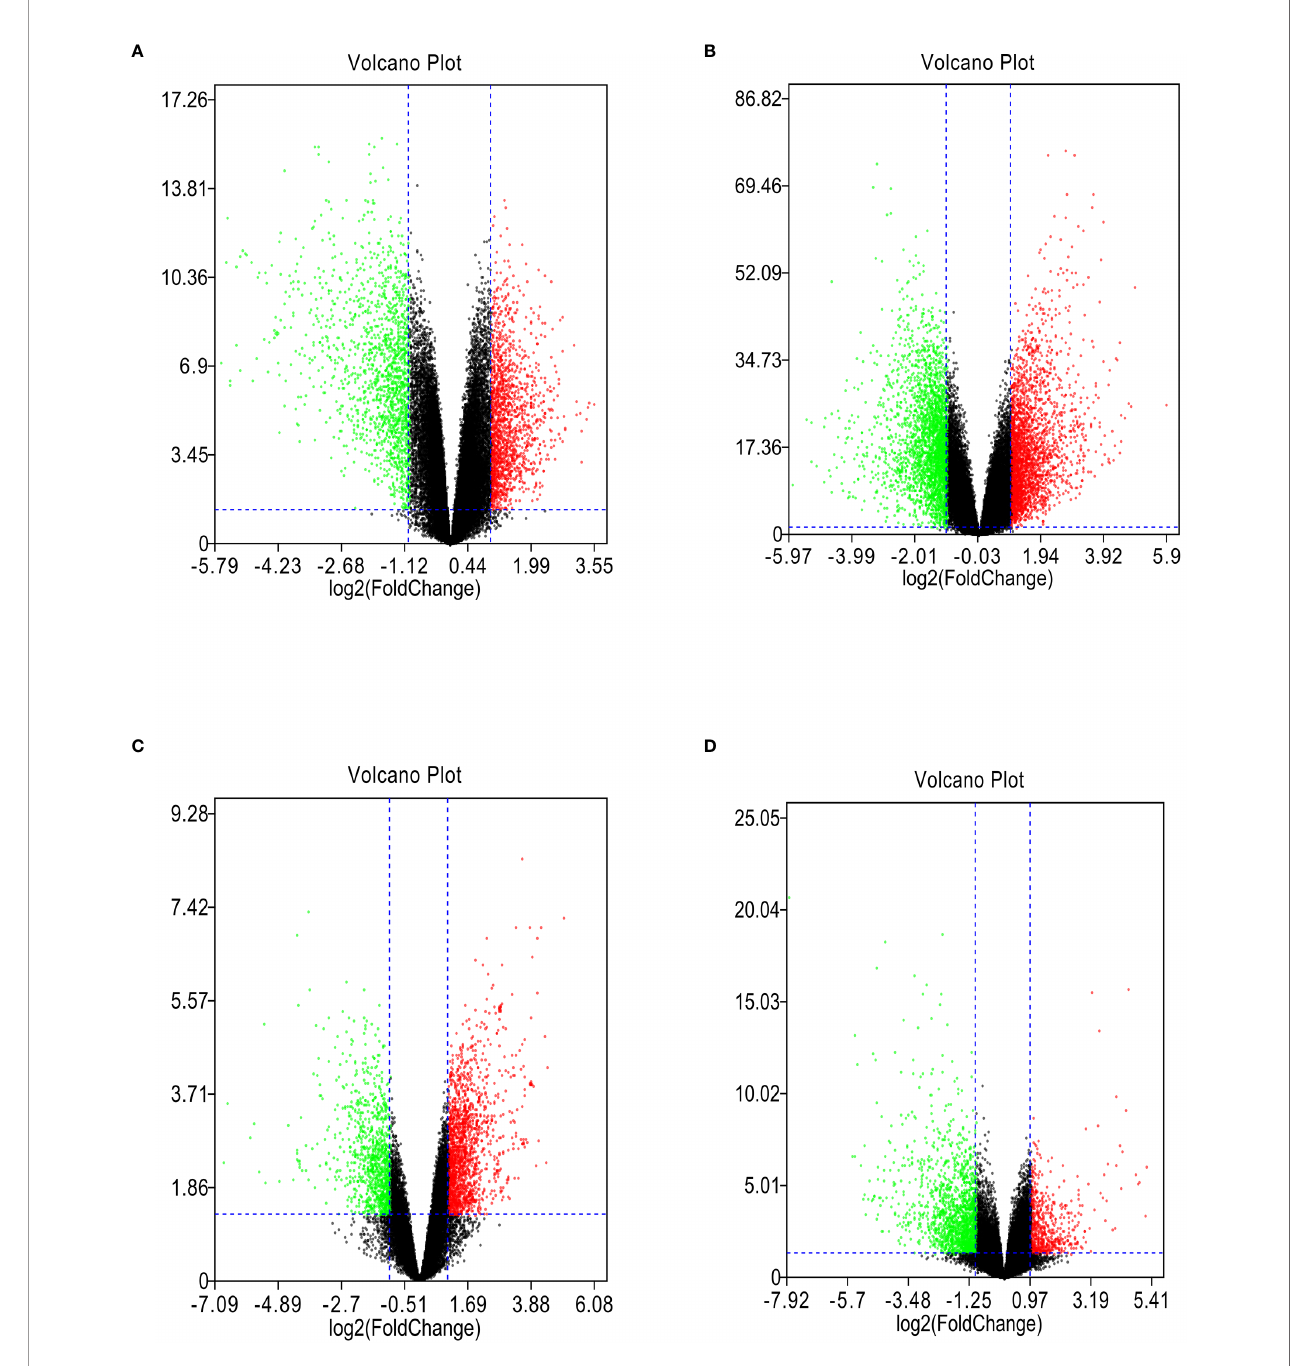
FIGURE 2 | (A) The volcano plot illustrates the differences between control and gastric cancer tissues after analysis of the GSE118916 dataset with GEO2R. (B) The volcano plot illustrates the difference between control and gastric cancer tissues after analysis of the GSE54129 dataset with GEO2R. (C) The volcano plot illustrates the difference between control and gastric cancer tissues after analysis of the GSE103236 dataset with GEO2R. (D) The volcano plot illustrates the difference between control and gastric cancer tissues after analysis of the GSE112369 dataset with